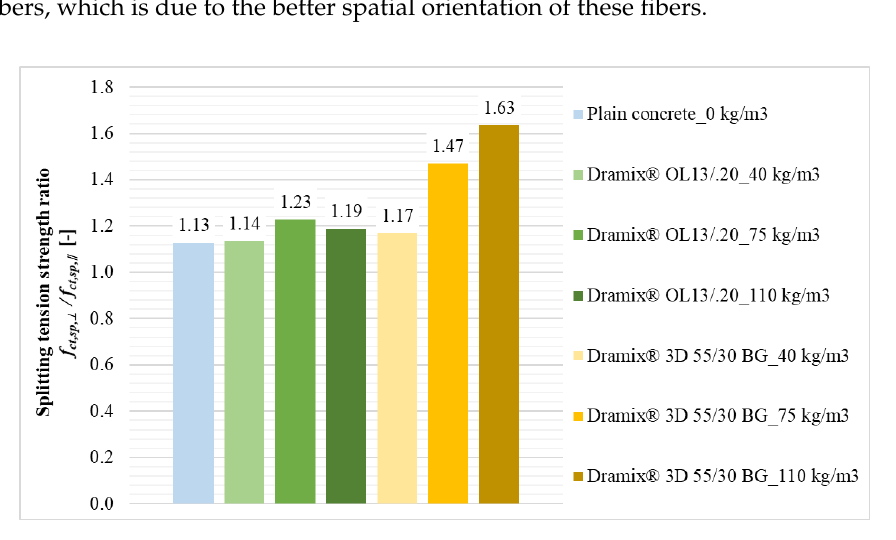
Table 3. Material properties of plain concrete and fiber-reinforced concrete: tensile strength.